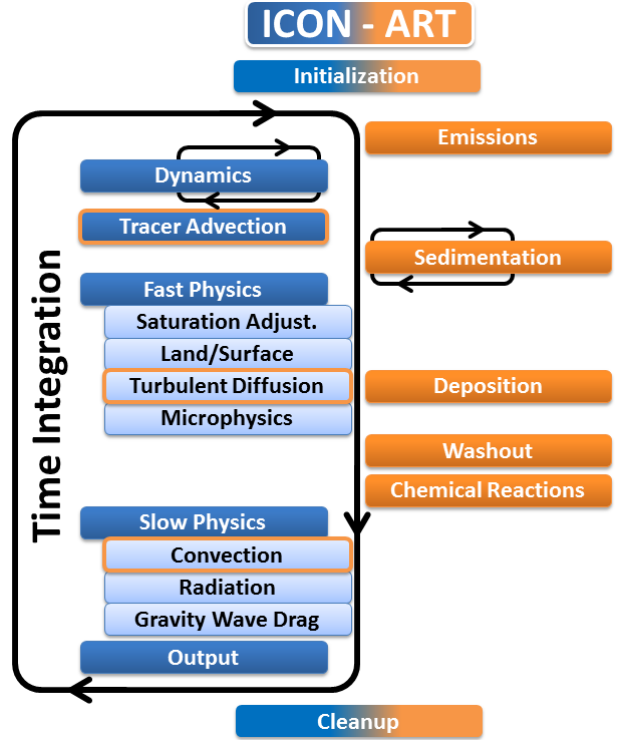
Figure 2. Schematic of the coupling of ICON–ART. The sequence in which processes of ICON are executed is illustrated by the blue boxes. Processes of ART are illustrated by the orange boxes. An orange frame around a blue box indicates, that the according code is part of the ICON tracer framework (see Sect. 2) but ART trac- ers are treated inside this framework. The black circle indicates the sequence of the time